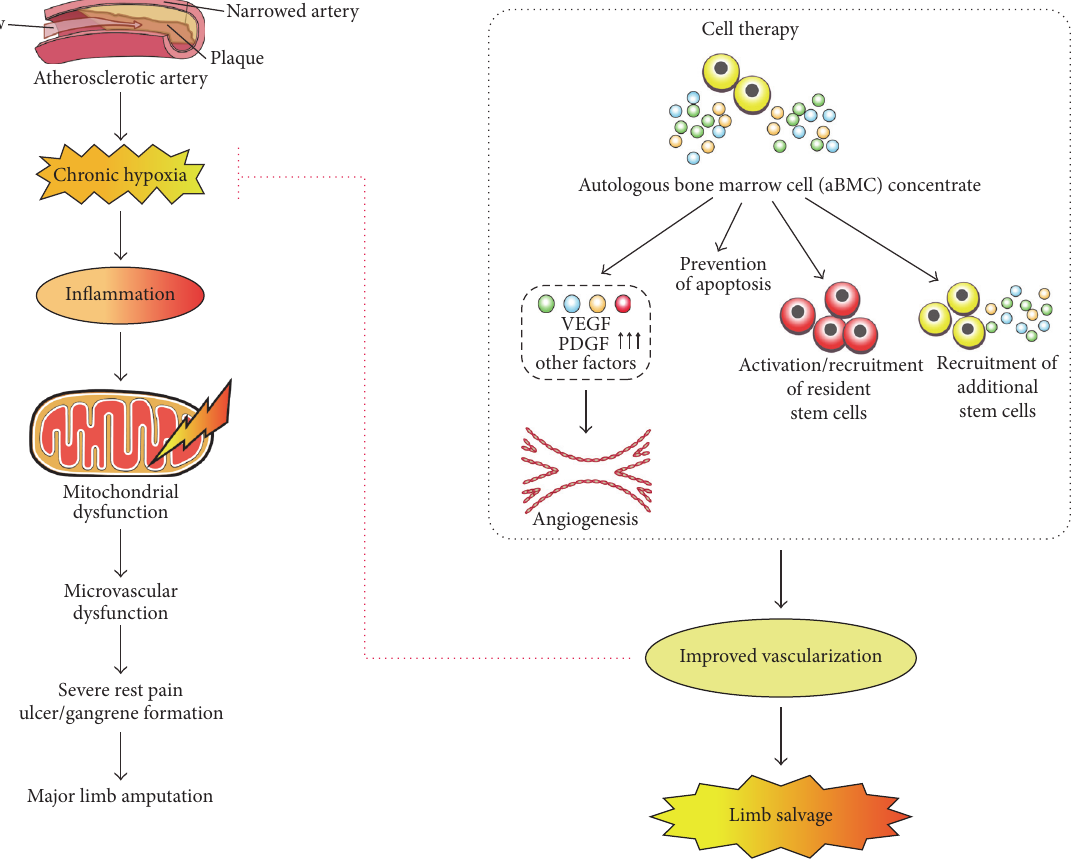
Figure 10: Diagrammatical representation of the mechanism of action of cell therapy in CLI